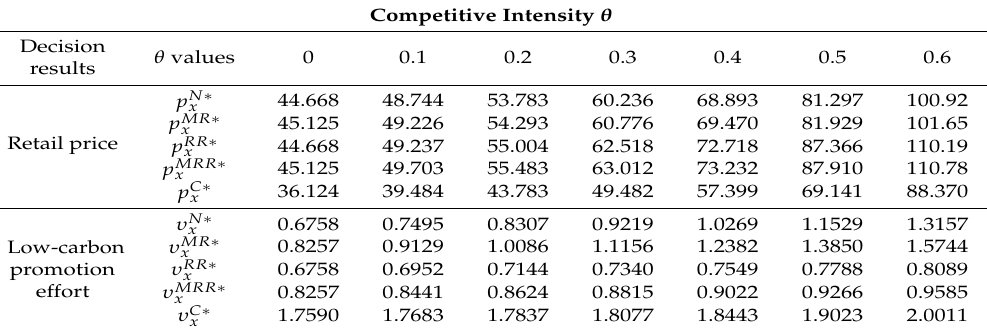
Table 3. The influence of competition intensity on the retailer’s decision results.